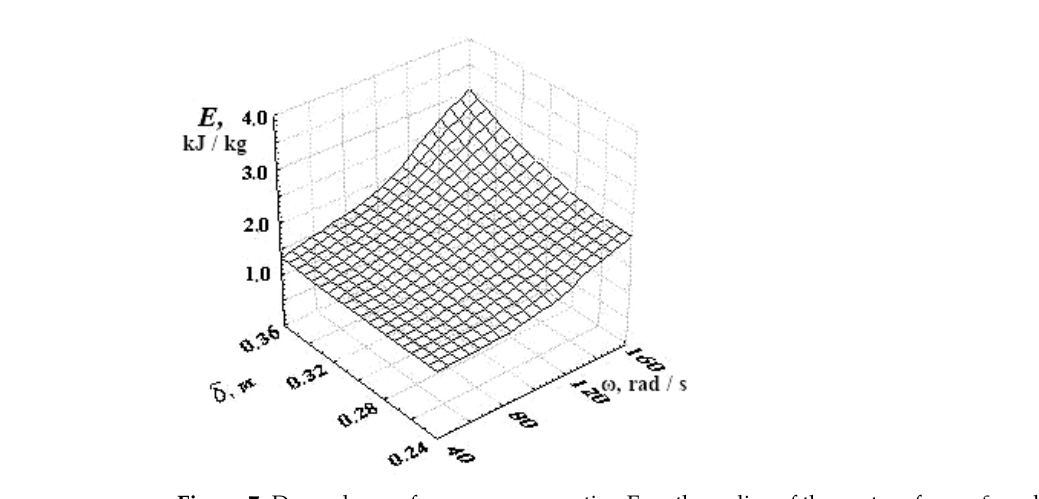
Figure 7. Dependence of energy consumption E on the radius of the center of mass δ , and the rotation speed of the rotary finger working body ω at α o = const.